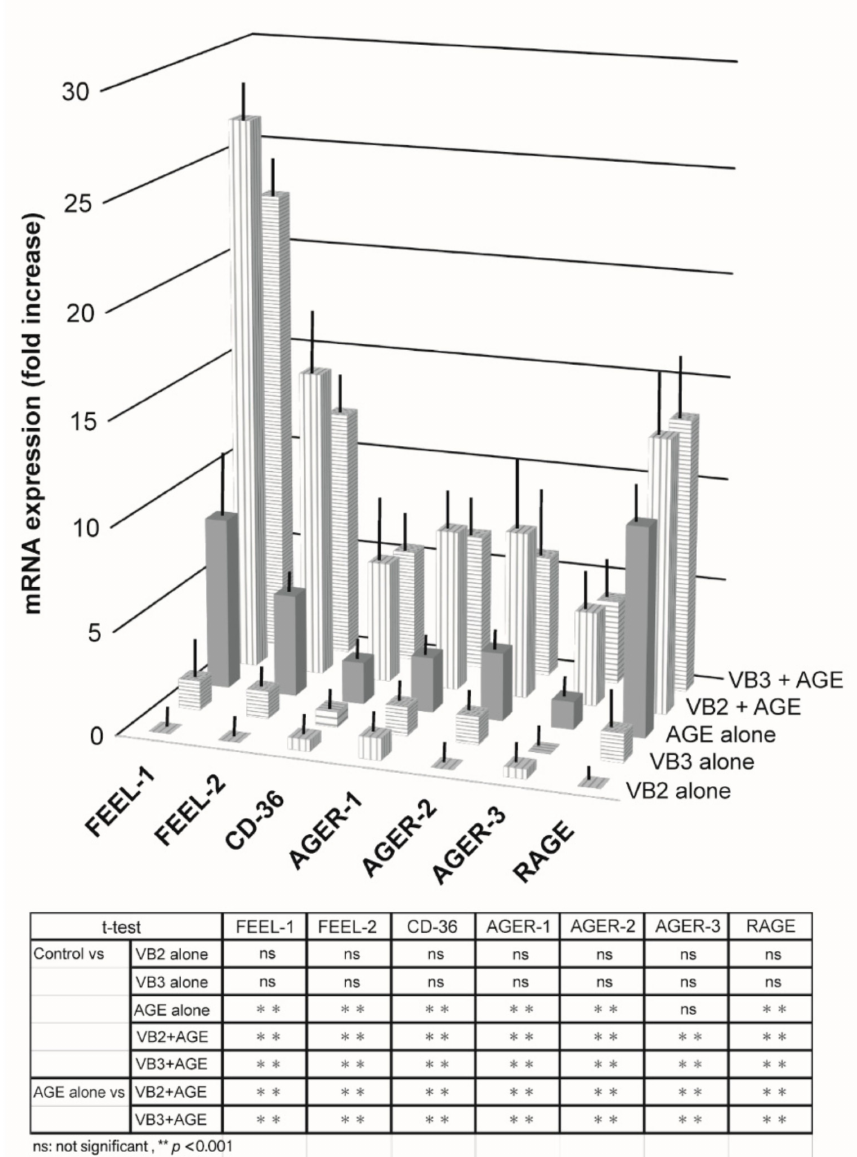
Figure 2. Effects of VBs on the mRNA expression of AGE receptors in NHDF treated with AGE. NHDF were incubated with 10 µ g/mL of VB2 or VB3 in the presence or absence of 100 µ g/mL AGE. Four hours after the incubation, the mRNA expression levels of AGE receptors were measured by qRT-PCR. The effects of VBs on AGE receptor mRNA expression were examined for significant differences from the untreated group. The effects of VBs on the mRNA expression of AGE receptors under AGE-induced stress conditions were analyzed in comparison with the response of AGE-treated cells alone. ** p <